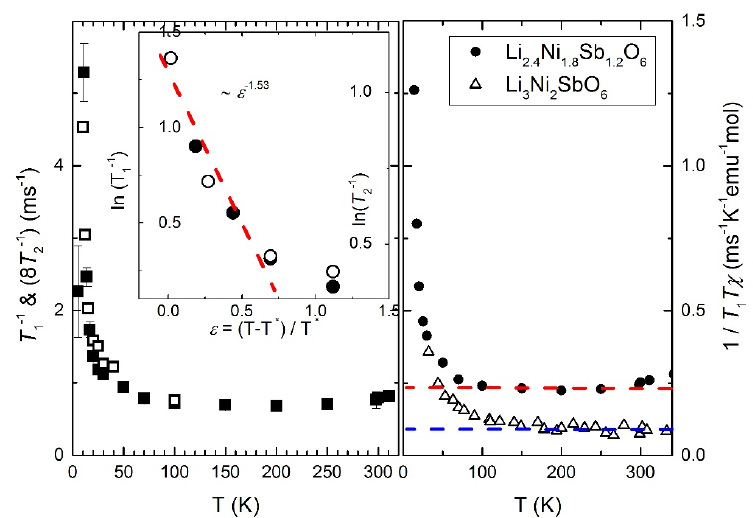
Figure 10. ( Left ) Temperature dependence of the 7 Li spin-lattice relaxation rate T 1 − 1 (solid squares) and transverse relaxation rate T 2 − 1 (open squares) for Li 2.4 Ni 1.8 Sb 1.2 O 6 at B = 0.724T. The inset shows a log-log plot of relaxation rate against the reduced temperature ε = | T − T crit |/ T crit ( T crit = 11.7 K). The dashed line represents fit with the critical exponent according to Equation (9). ( Right ) 1/( T 1 T χ ) as a function of temperature for stoichiometric (open triangles) and lithium-deficient (solid circles) samples. Dashed lines show constant level for Li 2.4 Ni 1.8 Sb 1.2 O 6 (red) and Li 3 Ni 2 SbO 6 (blue).